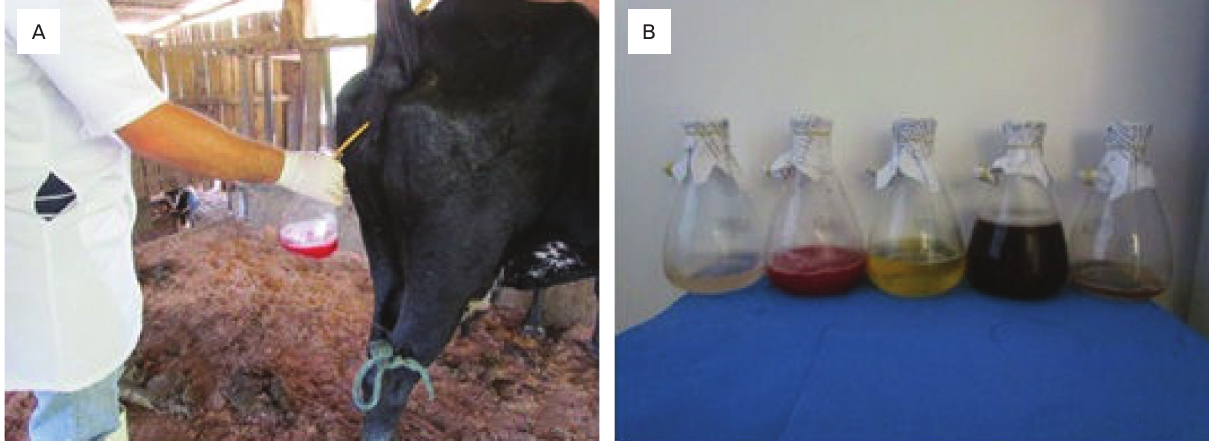
Figura 2. Recuperação do lavado vesical do grupo A. (A) Utilização do recipiente Erlenmeyer estéril com capacidade de dois litros para armazenagem de todo o lavado vesical obtido; (B) amostras devidamente identifi cadas após a